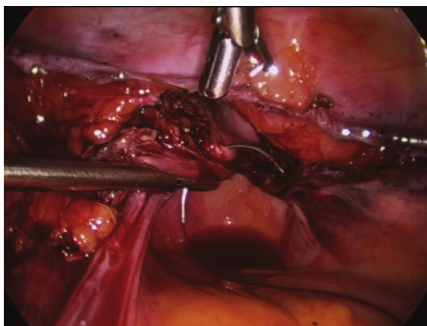
Figure 2: The suture is passed into the posterolateral vagina 5 mm deep to the cut edge.